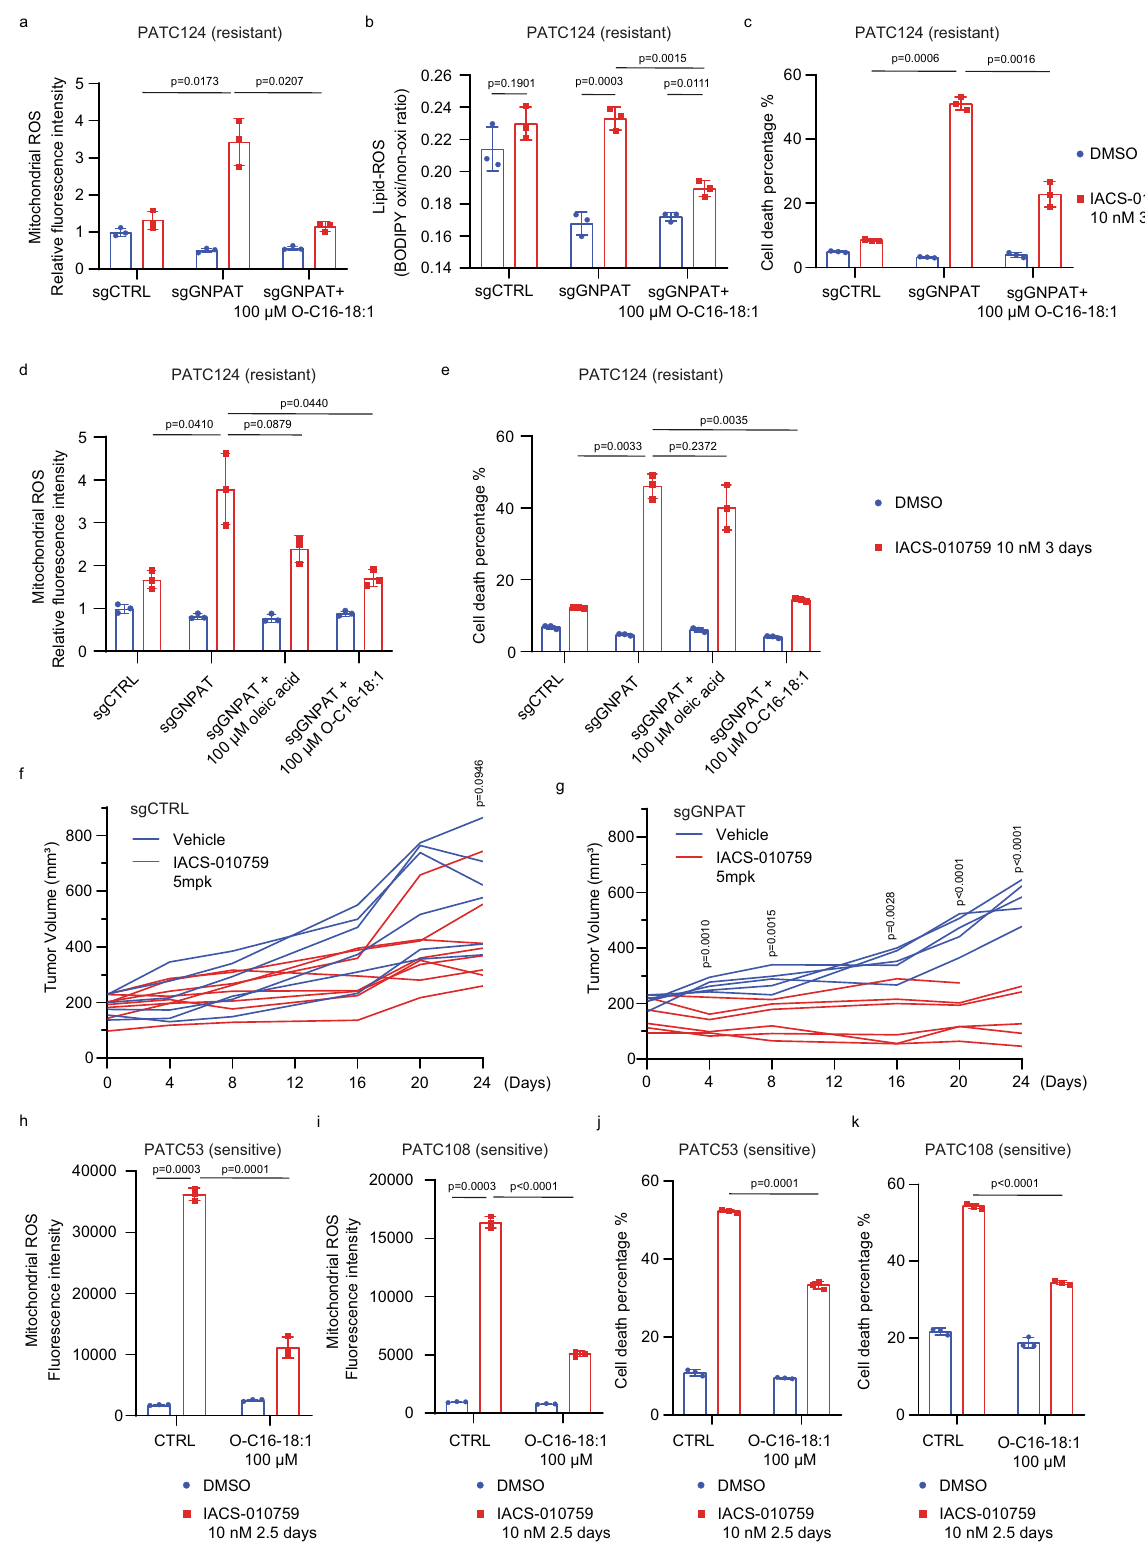
Metabolic stress assays Mitochondrial reactive oxygen species (ROS) and lipid peroxida- tion detection . A total of 3 ×10 5 PATC cells were plated and treated with indicated compounds for speci fi ed durations. Cells were har- vested, washed with cold PBS, and stained with 5 μ M MitoSOX (Life Technologies, #M36008) or 1 μ M BODIPY 581/591 C11 (Thermo